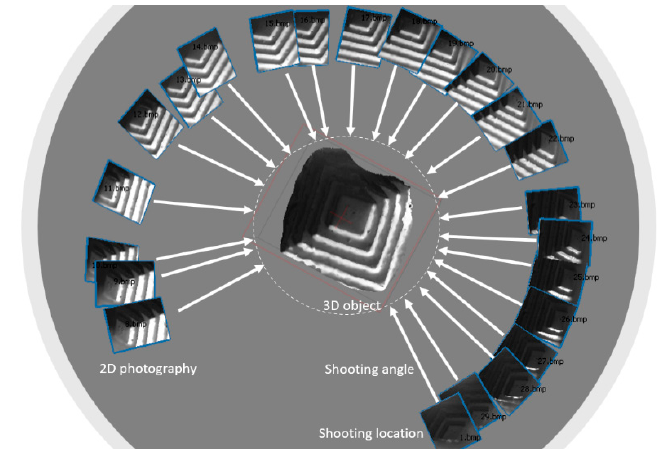
Figure 1. The concept of the Structure from Motion (SfM) technique .